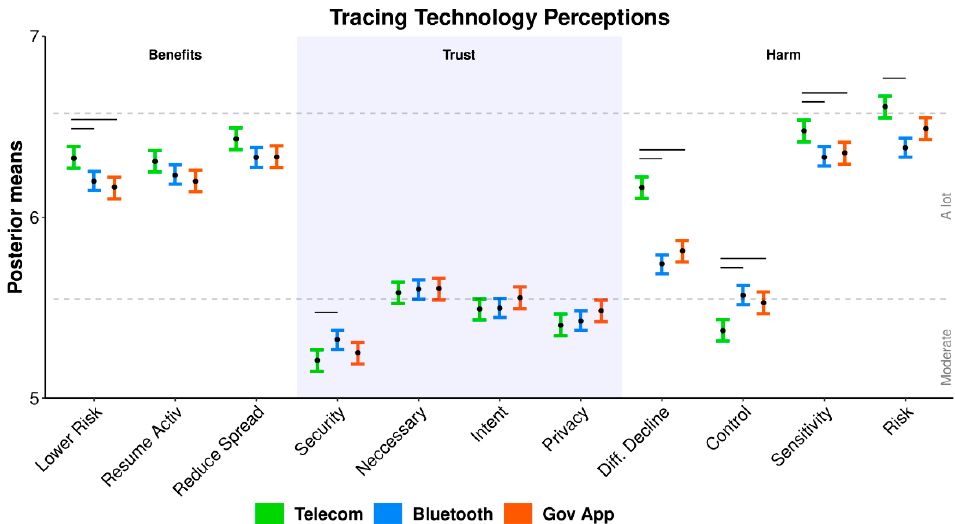
Figure 3. Ordinal regression mean posterior distributions for items assessing perceptions of each hypothetical tracing technology. Colored error bars display the 95% highest posterior density interval (HDI), black dots display the posterior mean, and black lines display where HDIs do not overlap within an item. Dotted lines depict boundaries separating the latent space into ordinal responses (1 = none to 6 = extremely; 4 = moderate).